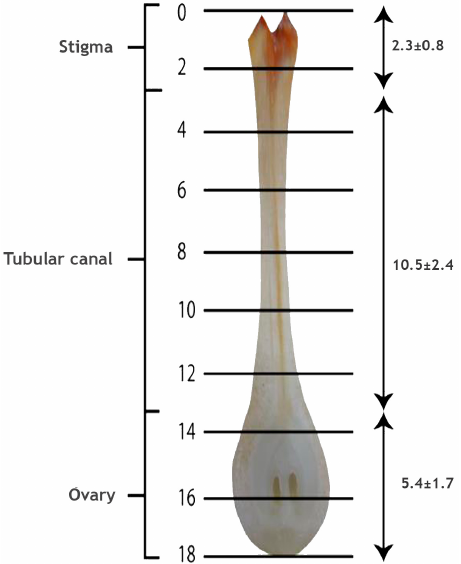
Figure 3. Longitudinal section of pistil of the coconut variety WCT. The cross lines from 0 to 18 indicate the length in mm (mean ± SD) of the stigma, tubular canal and ovule-bearing region.